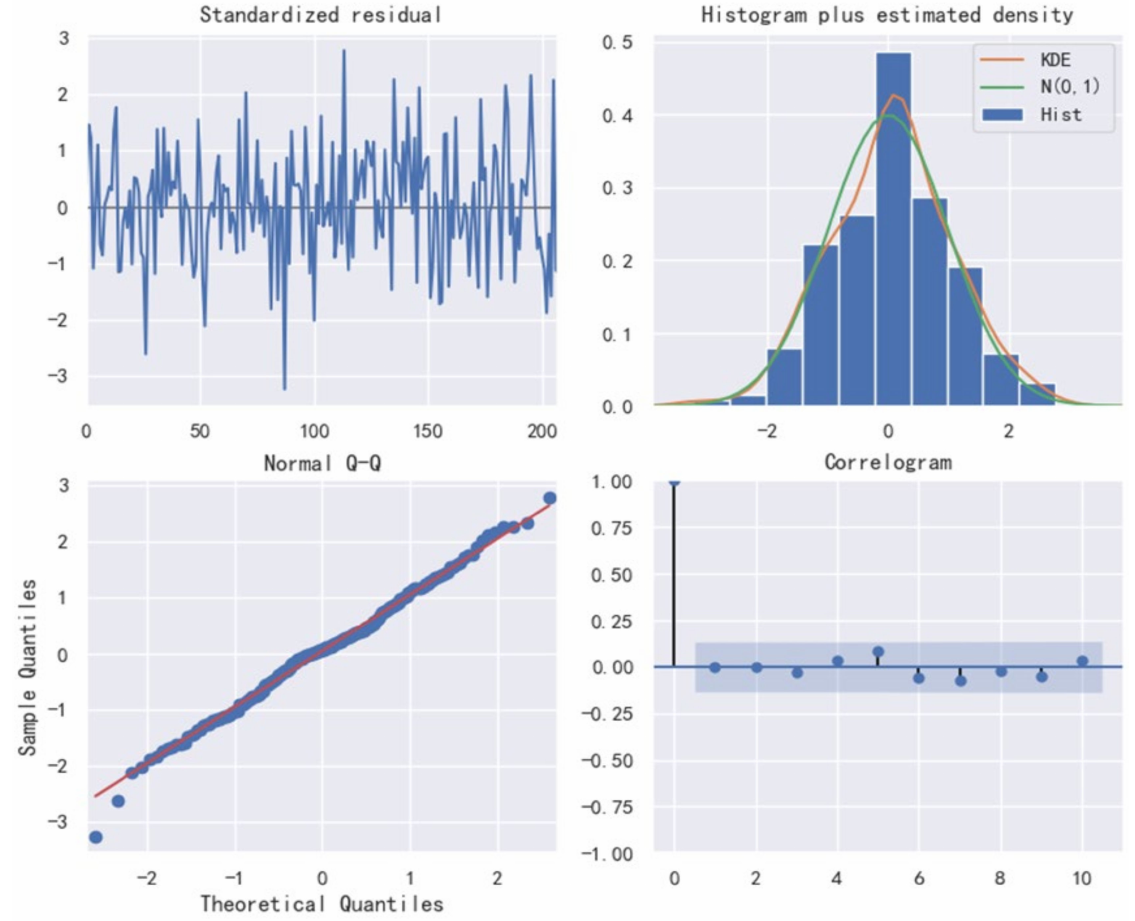
Figure 9. Other methods for estimating parameter performance.